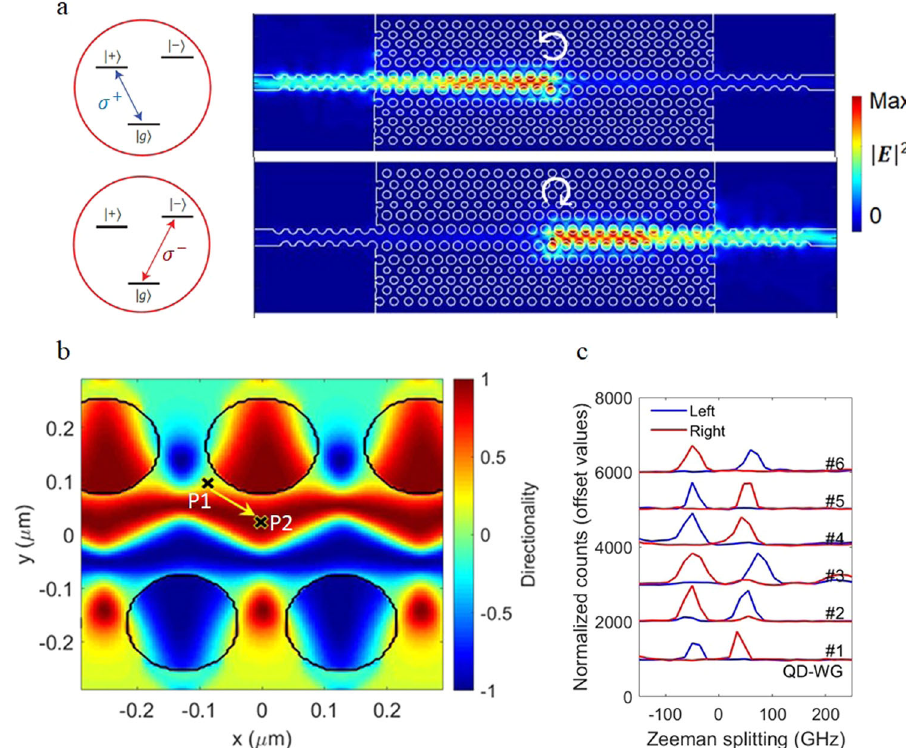
Fig. 3 Chiral routing of spin-carrying photons. a Simulated electric- fi eld pro fi le of the waveguide mode propagating along the line defect with a direction being determined by the spin state of the emitted photons from an embedded QD. The inset shows two transition dipole moments of σ þ and σ (cid:2) with orthogonal circular polarization. b Calculated directionality for circularly polarized dipoles as a function of position relative to the glide-plane waveguide structure. The degree of circular polarization of the internal electric fi eld determined the chiral regions of the waveguide. Two local waveguide points of P1 and P2 represent extreme cases with zero directionality (linearly polarized light fi eld) and pure circularly polarized light fi eld (chiral point), respectively. c Optical measurement for QDs located in 6 different waveguides. The red and blue lines represent the photon collection from the left and right out-couplers, respectively. The Zeeman components of the QDs in an out-of-plane magnetic fi eld of B = 3 T have opposite circular polarizations. The results indicate a strong chiral coupling of QDs into the waveguide